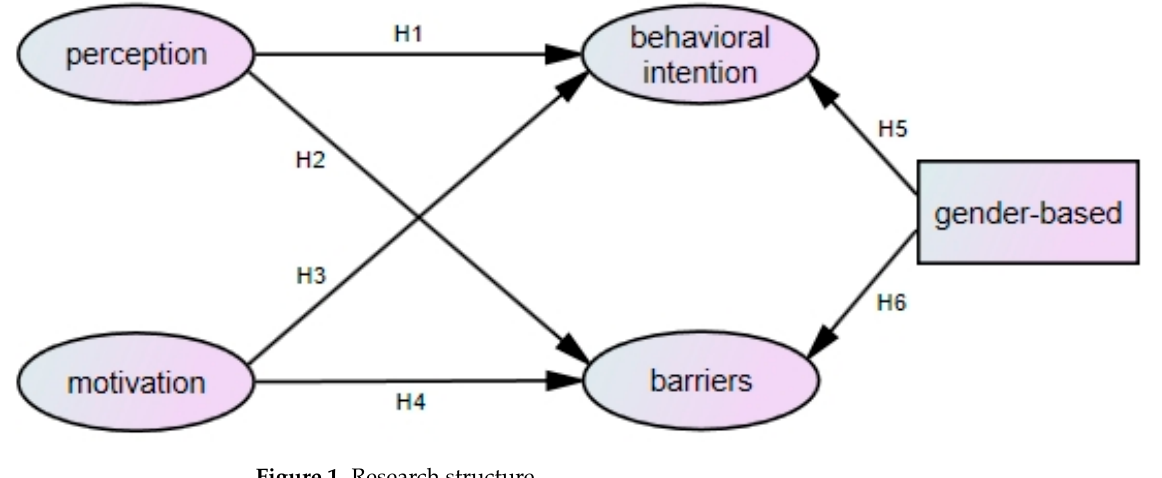
Figure 1. Research Figure 1. Research structure.